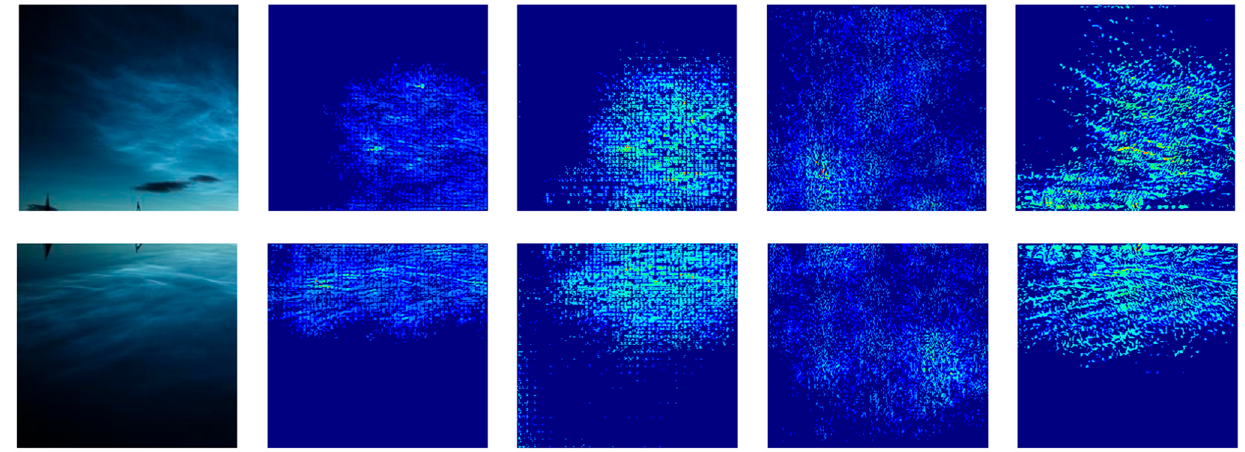
Figure 5. Test image and their saliency map for NLC class.